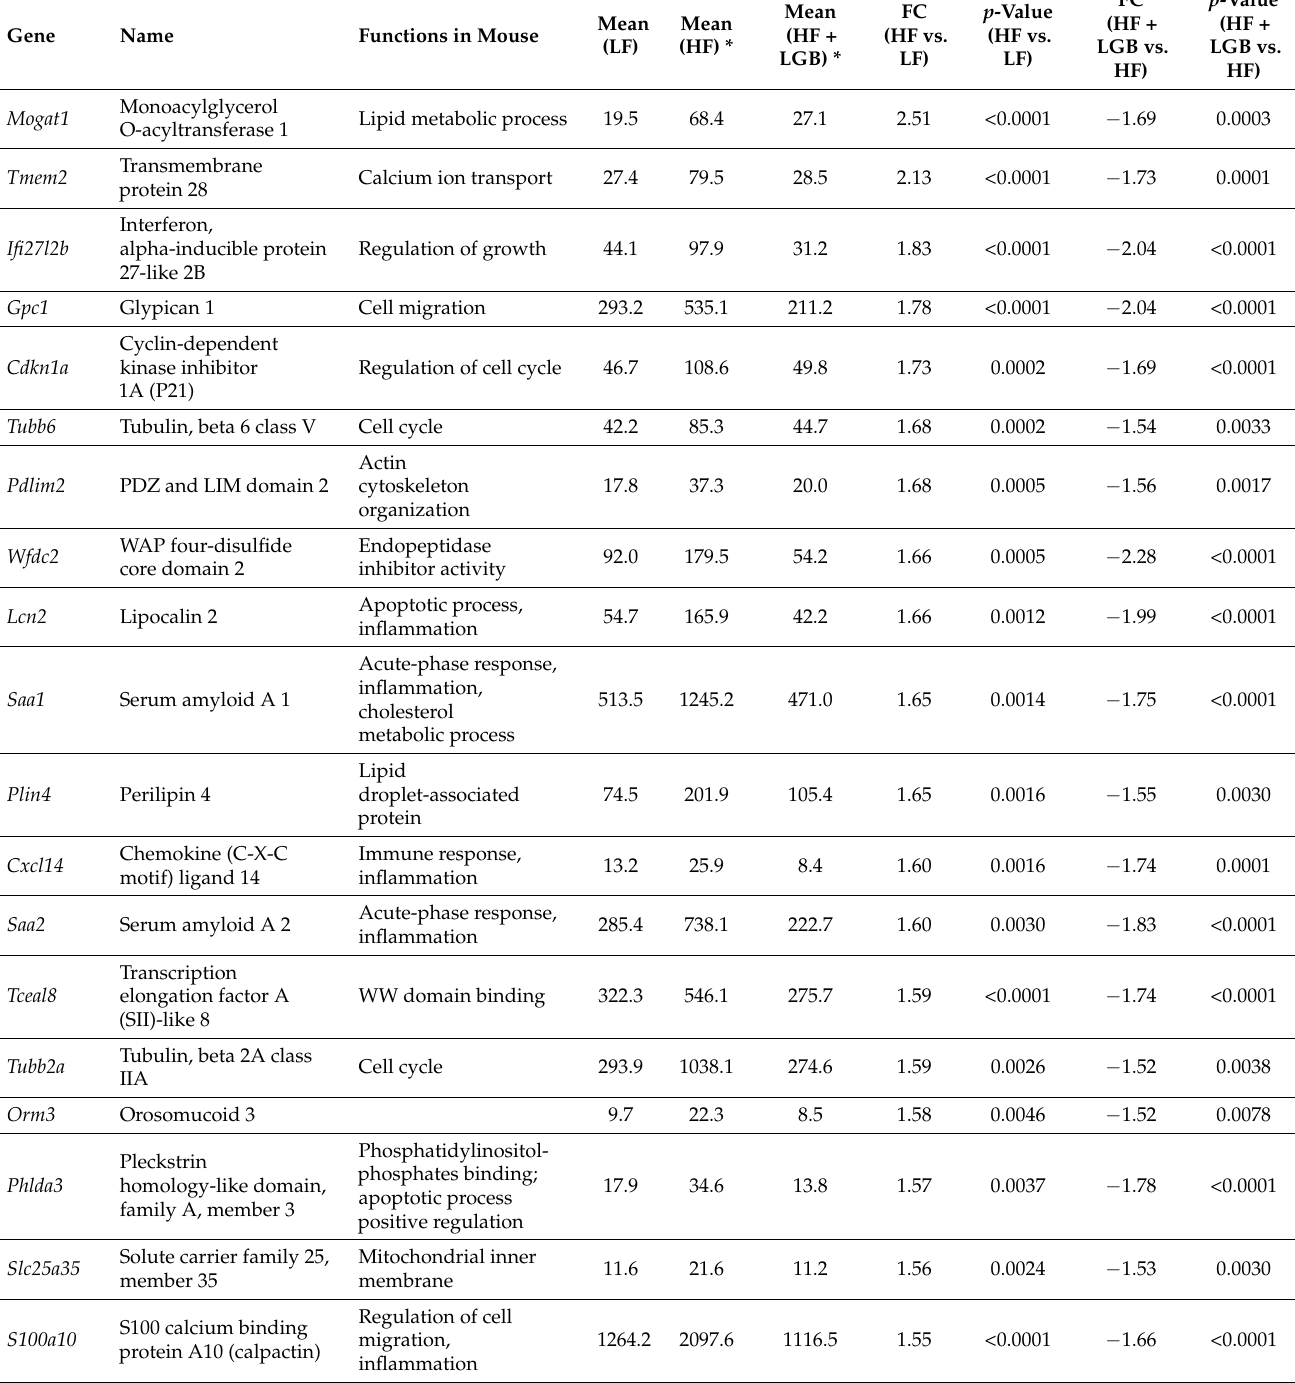
Table 5. The 21 genes upregulated by the high-fat (HF) diet (FC > 1.5), and whose expression was significantly lower in the lingonberry-supplemented high-fat diet group (HF + LGB) (FC < − 1.5), and the 2 genes (last two rows) downregulated by the high-fat (HF) diet (FC < − 1.5), and whose expression was maintained at higher expression level in the lingonberry- supplemented high-fat diet group (HF + LGB) (FC > 1.5). Mean expression levels are given as DESeq2-normalized counts. p -values are adjusted by false discovery rate (FDR). * Mean of normalizations performed in comparisons HF vs. LF and HF + LGB vs. HF. LF = low-fat